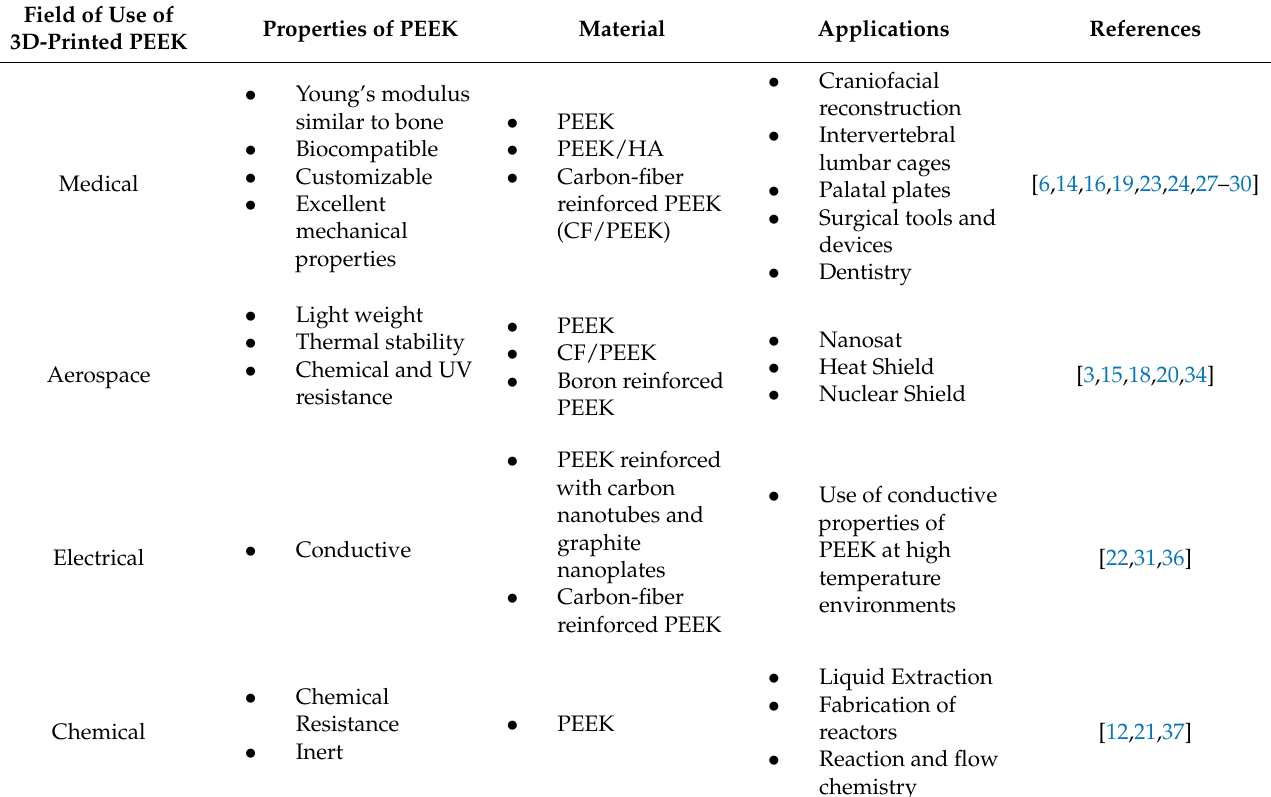
Table 1. Summarizing the application and use of 3D-printed PEEK in different